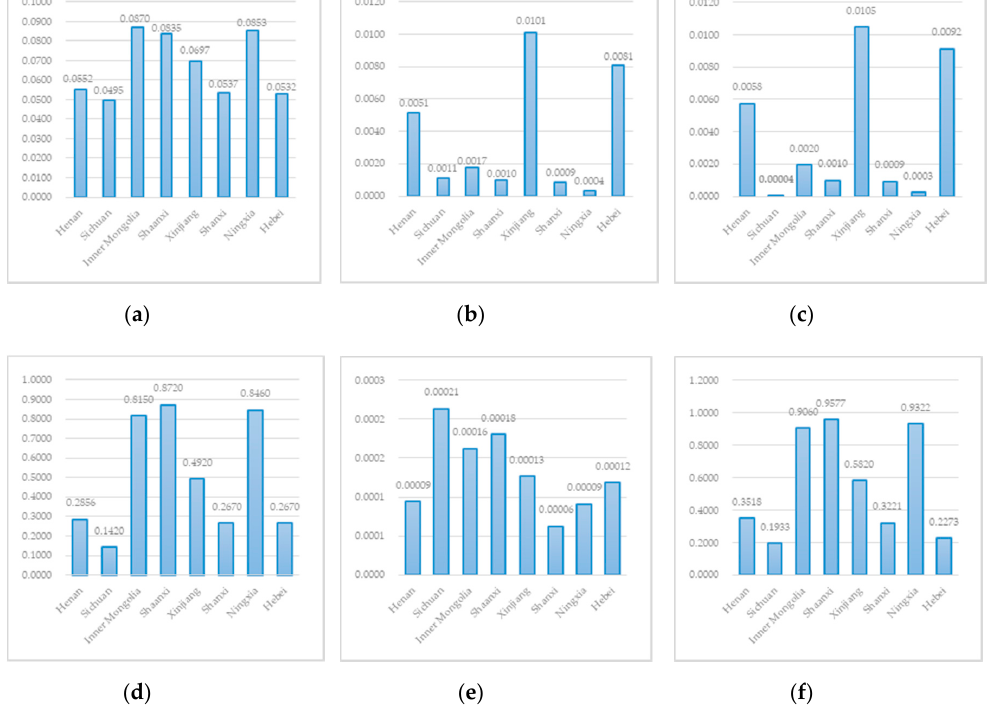
Figure 5. Environmental impact potentials of the eight provinces in the nature gas liquefaction process (per unit): ( a ) Global Warming Potential (GWP), ( b ) Acidification Potential (AP), ( c ) Eutrophication Potential (EP), ( d ) Photochemical Ozone Creation Potential (POC), ( e ) Dust Potential (DP), and ( f ) Total Environmental Impact Potential.